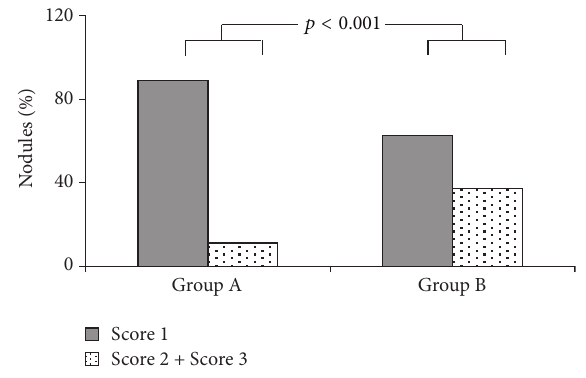
Figure 2: Elasticity score in nodules with benign diagnostic cytol- ogy in relation to thyroid hypoechogenicity